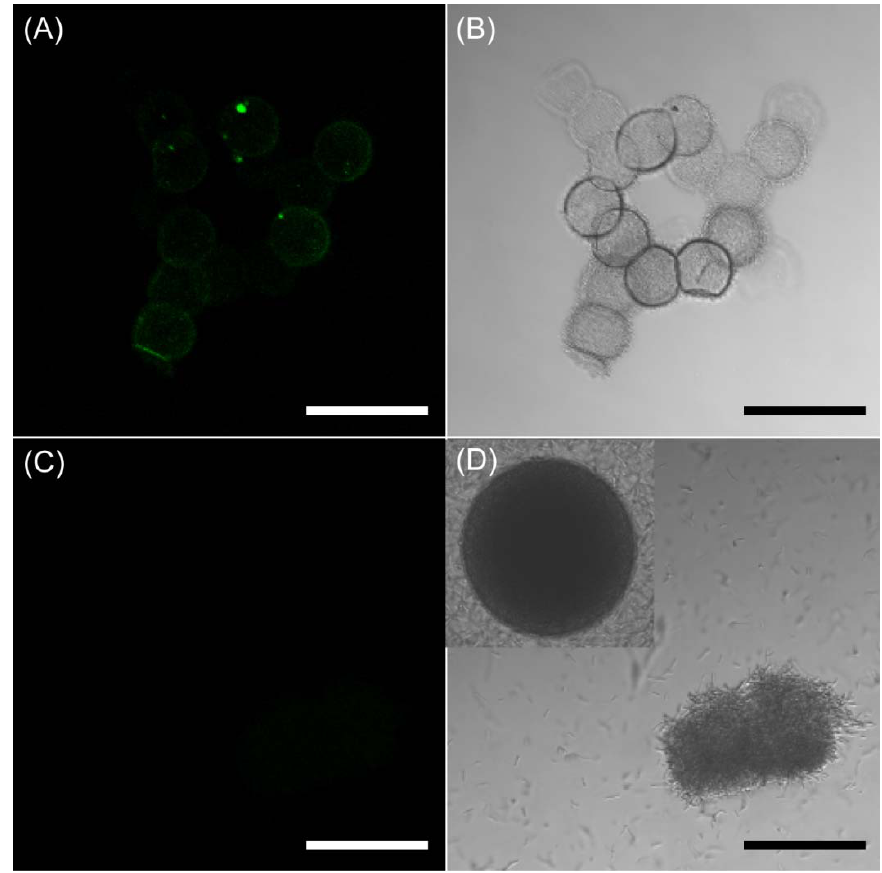
Figure 5. BT spore encapsulated in the hydrogel microcapsules. Fluorescent image of BT spore inside of microcapsules before the germination ( A ) and its optical image ( B ); Fluorescent image of microcapsules after the germination ( C ) and its optical image ( D ). Scale bars represent 100 μ